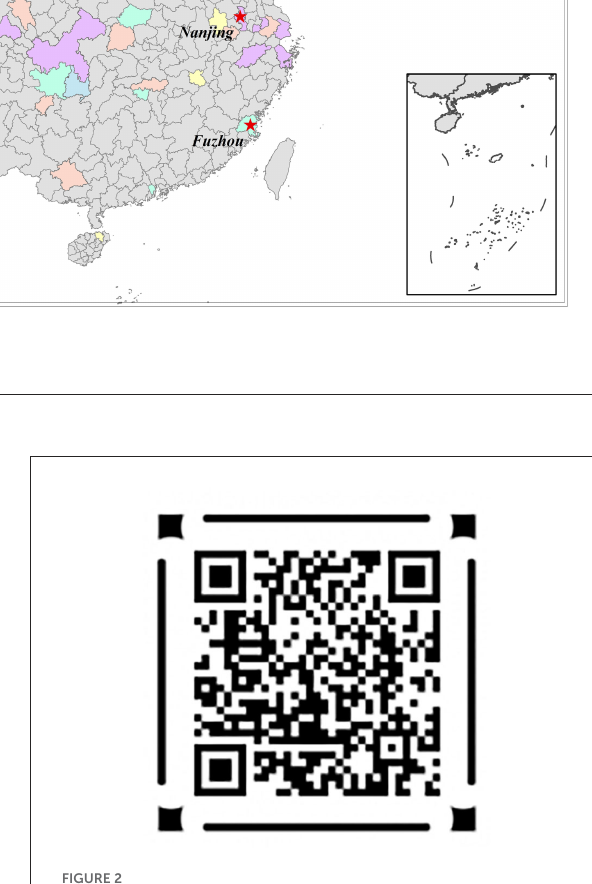
FIGURE2 Blockchain traceability QR